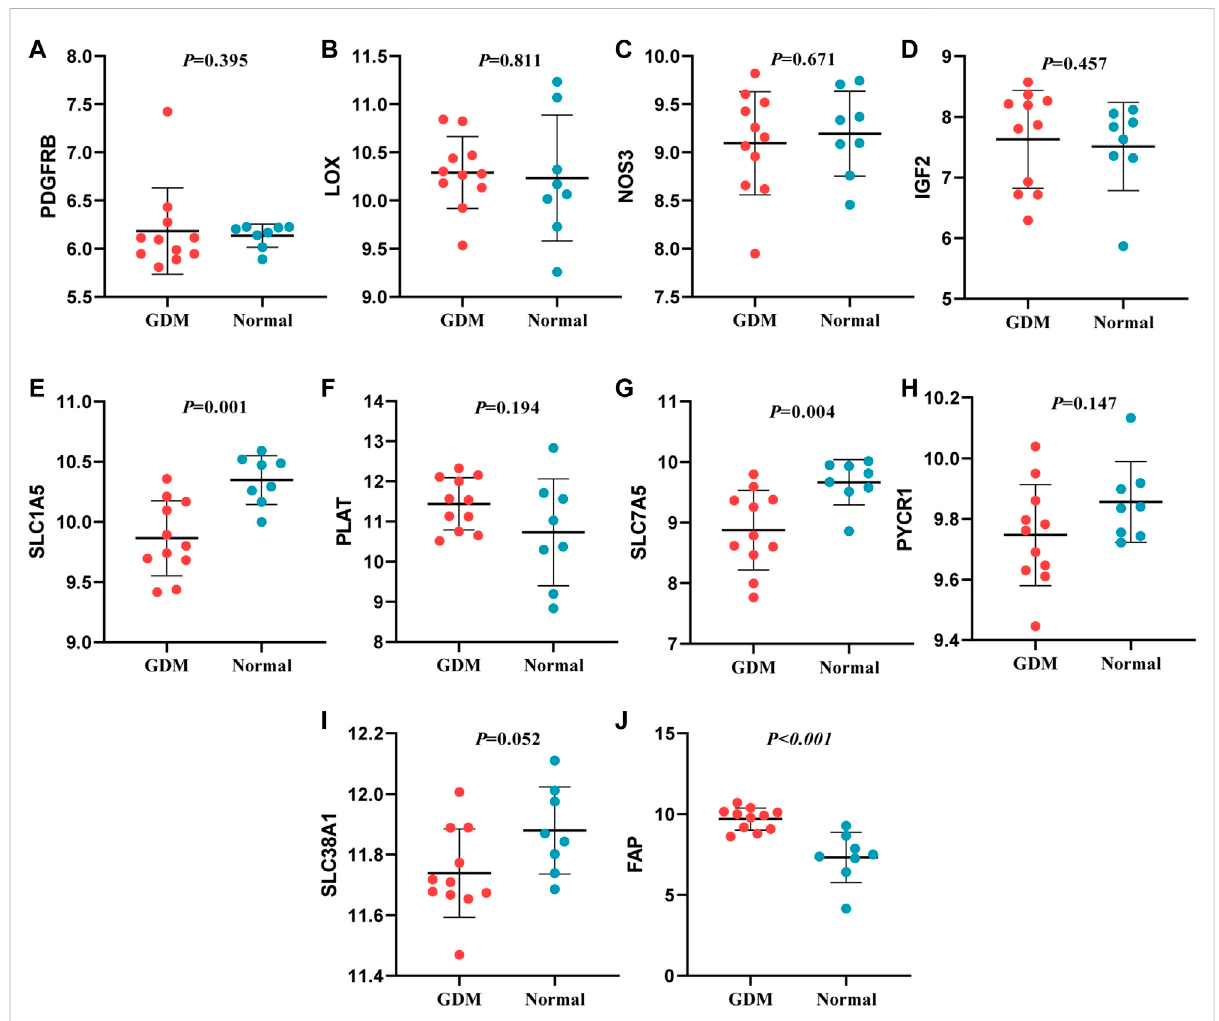
FIGURE 9 Veri fi cation of down-regulated genes. (A) : PDGFRB (B) : LOX (C) : NOS3 (D) : IGF2 (E) : SLC1A5 (F) : PLAT (G) : SLC7A5 (H) : PYCR1 (I) : SLC38A1 (J) : FAP.